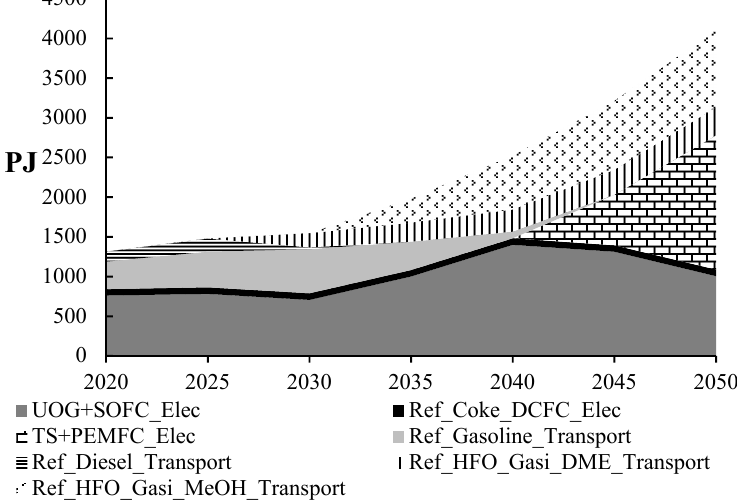
Figure 6. Energy/technology mix for Scenario 3 (CO 2 cap of 65704 (15% reductions of Scenario 1) by 2030 maintained till 2050 and ban on oil combustion for power generation).